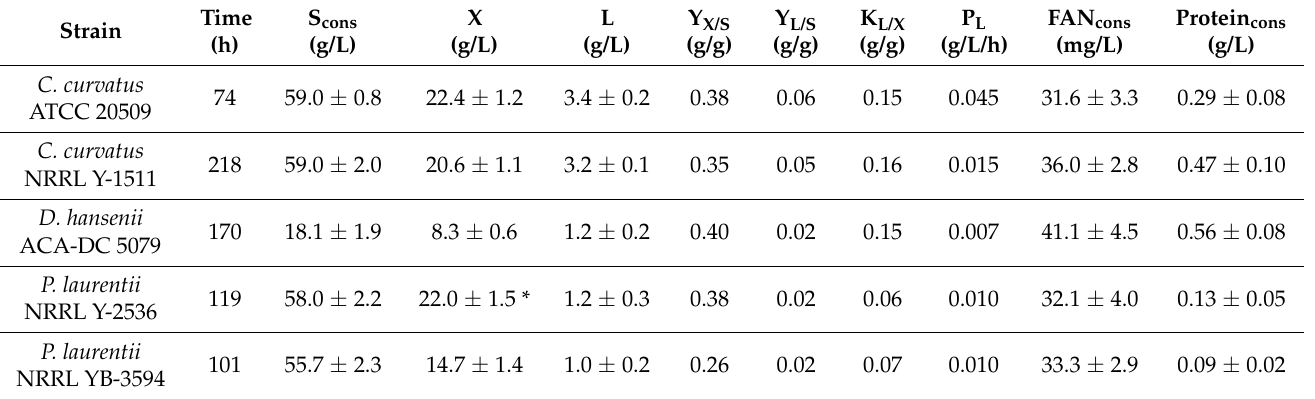
Table 4. Quantitative data originated by kinetics of five microorganisms, cultivated in the complex substrate, treated second cheese whey, with initial lactose (S0) c. 60 g/L. Culture conditions as in Section 2; standard error for most experimental points was ≤